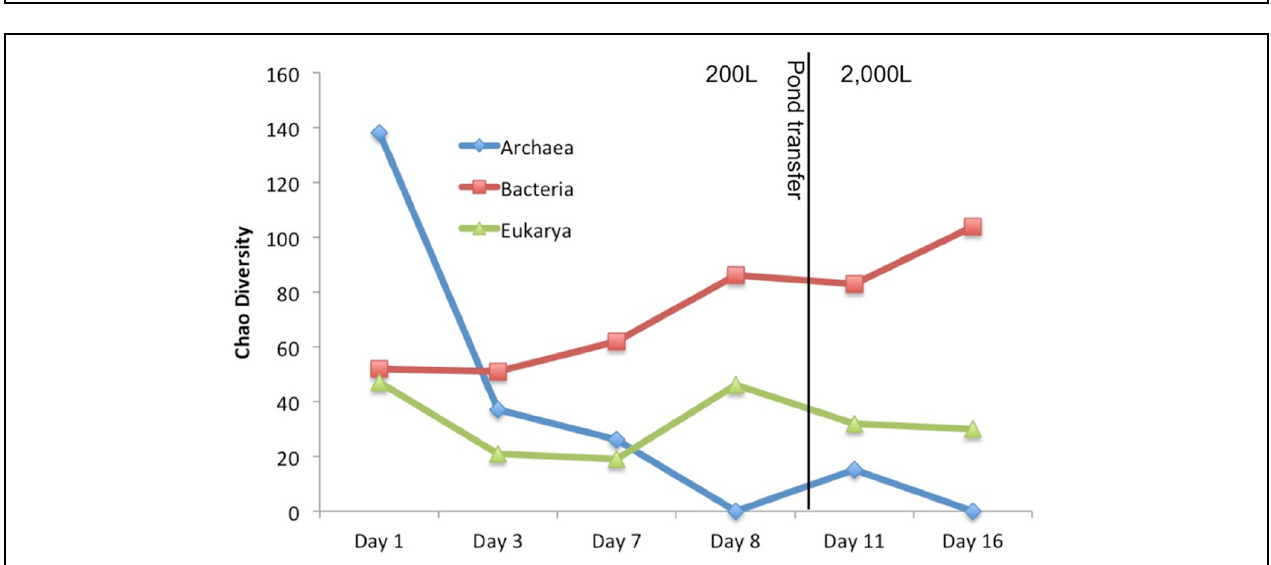
FIGURE 3 | Chao diversity for each domain plotted over time. Archaea started with high diversity but quickly declined. Eukarya maintained a steady diversity level composed almost entirely of C. vulgaris . Bacterial diversity steadily increased with